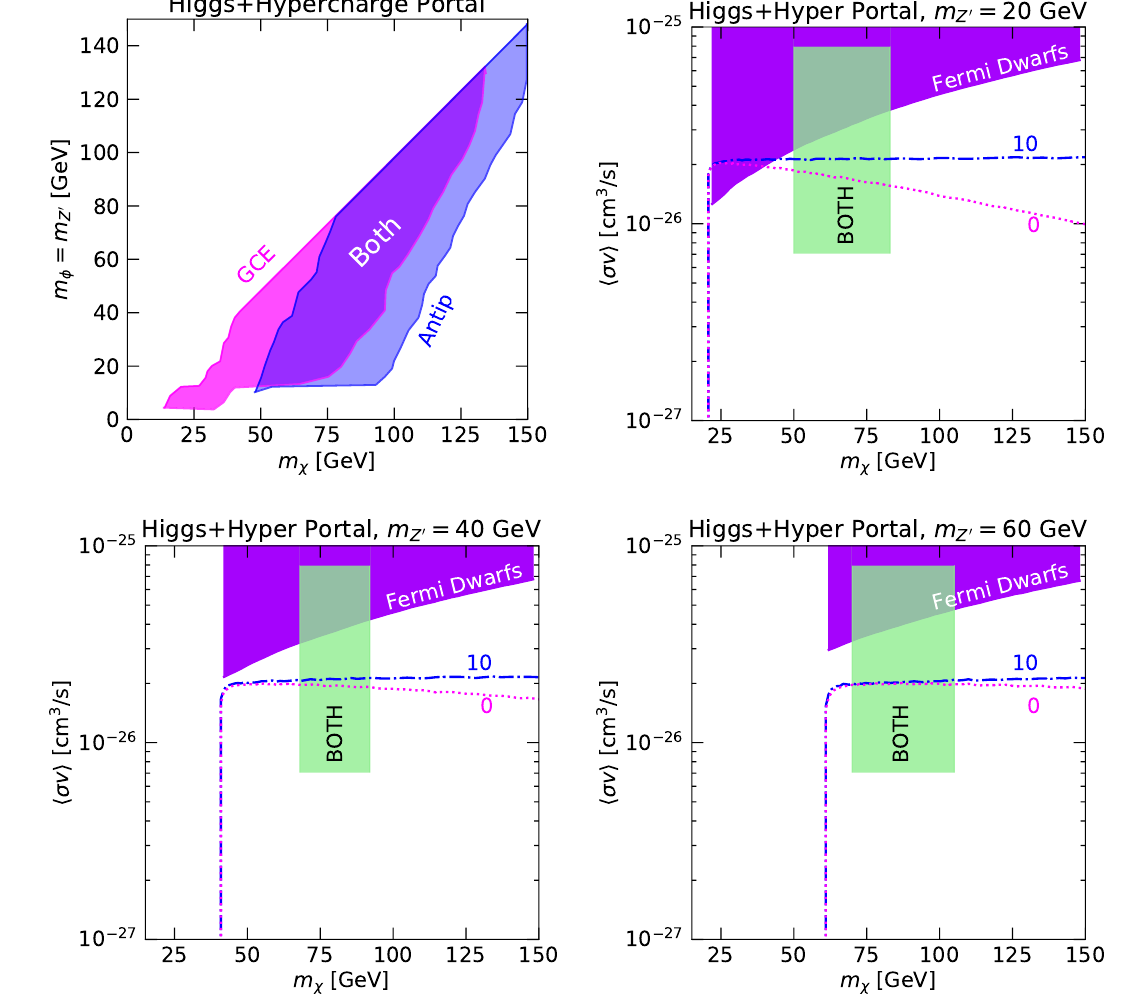
Figure 10 . As in the previous (cid:12)gures, but for the case of hidden sector dark matter that annihilates to particles that decay through both the hypercharge and Higgs portals. We have chosen to show results here for the case of m (cid:30) = m Z 0 . For consideration of other values of m (cid:30) =m Z 0 , see refs. [34, 40]. In this (cid:12)gure, we have taken the dark matter candidate to be a Dirac fermion with equal vector, axial, scalar, and pseudoscalar couplings. We have also introduced an interaction of the form (cid:22)(cid:30)Z (cid:22) Z (cid:22) , and show results for (cid:22) = 0 and 10 GeV.